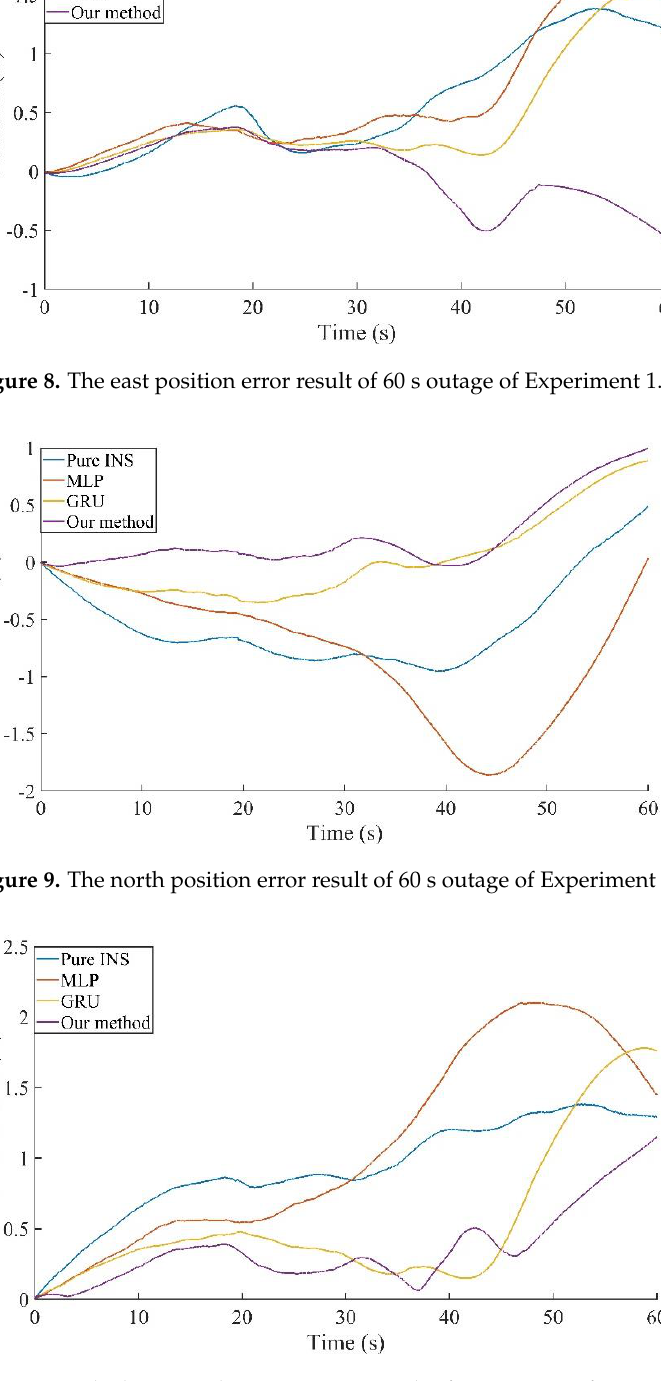
Figure 11. The trajectories of 60 s outage of Experiment 1. Table 2. Maximum position error of 60 s outage of Experiment 1. East Error (m)